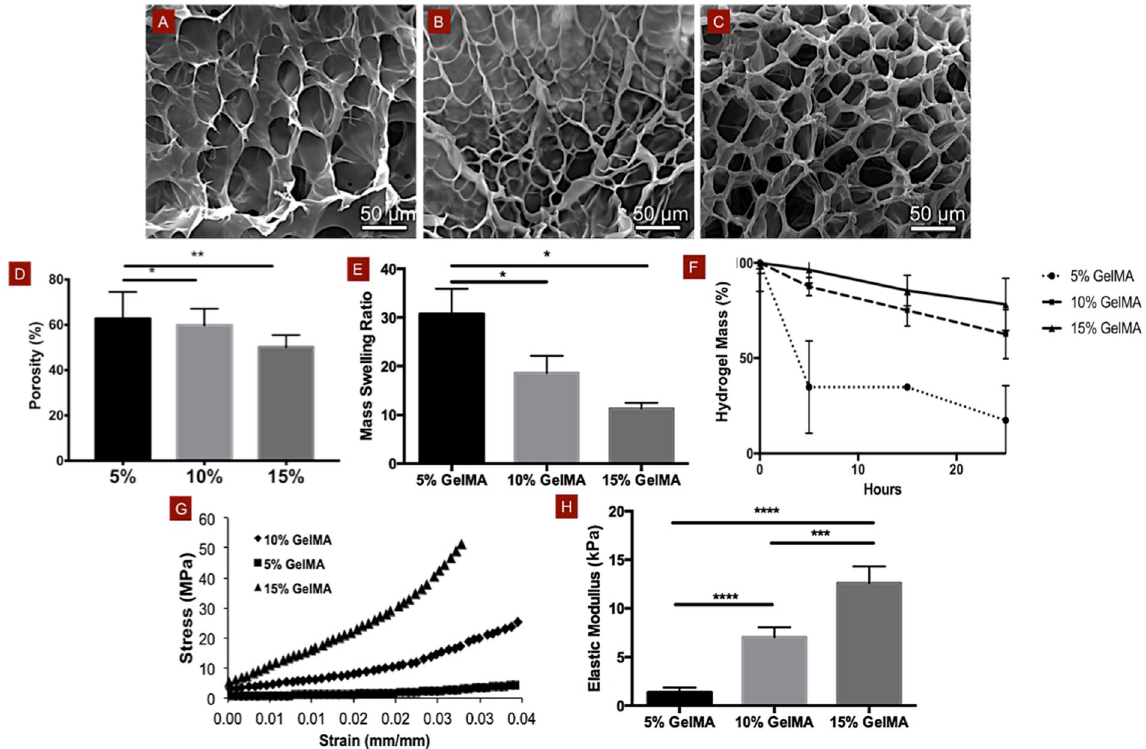
Figure 2. Physical and mechanical properties of GelMA hydrogels. SEM images of ( A ) 5%, ( B ) 10% and ( C ) 15% (w/v) GelMA hydrogels show a decrease in apparent pore sizes and (d) relative percentage of porosity with increasing hydrogel concentration, especially comparing 5% to 10 or 15% hydrogels. Mass swelling ratios and ( E ) degradation profiles of 5, 10 and 15% GelMA hydrogels in DPBS, and in 2.5 U ml –1 collagenase, respectively showing a marked decrease in swelling properties and degradability with increasing polymer volume fraction. ( F ) Stress-strain curves and ( G ) elastic modulus for 5, 10 and 15% GelMA hydrogels in unconfined compression, respectively demonstrate enhanced mechanical properties in more densely crosslinked hydrogels (15%). For degradation data, p < 0.0001 between 5% and 10%, and between 5% and 15% for time points 15 and 25 h. Statistical significance is represented by * for p < 0.05, ** for p < 0.01, *** for p < 0.001 and **** for p <